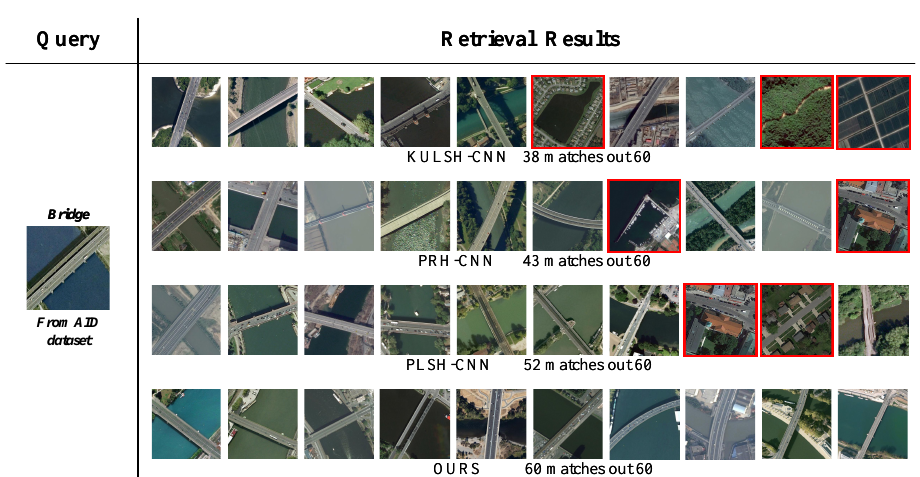
Figure 13. Retrieval results of “bridge” in the AID dataset by different competitive baseline methods. The single image in the left column is the query sample. Each row in the rest of the columns is the top-10 retrieval results from each comparable method. The results with red rectangles are incorrect, and the number of true positive results out of the top-60 retrieved images is also